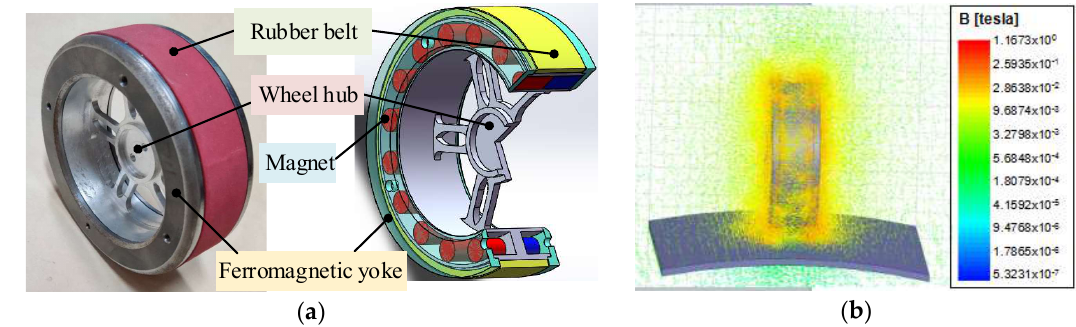
Figure 2. Magnetic wheel. ( a ) Schematic diagram and object; ( b ) magnetic simulation results.